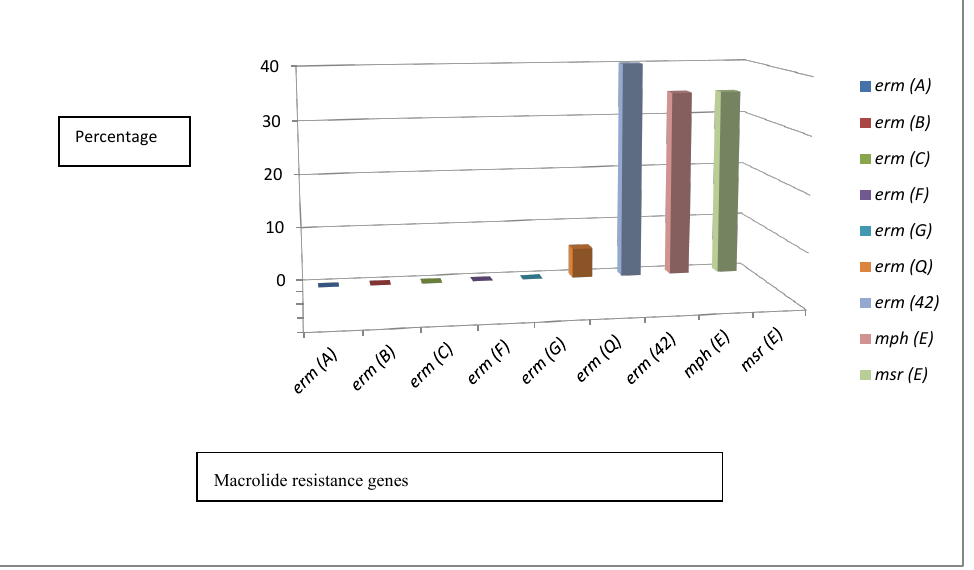
Figure 4. The results of macrolide–lincosamide–streptogramin B (MLS B ) methylases, monomethyltransferase, macrolide efflux pump, and macrolide-inactivating phosphotransferase genes.